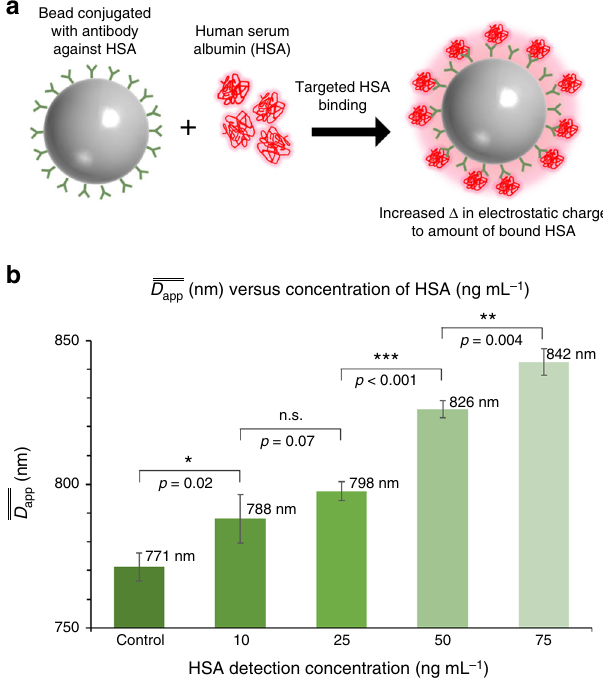
Fig. 6 Detection of HSA using antibody coated beads. a Schematics showing the detection of human serum albumin with the capture of antibody for higher detection sensitivity. b Three sets of readings were performed for the detection of HSA from 10 to 75 ng mL − 1 ( n = 3). D app represents the mean of mean D app for the three data sets with SD as the error bars (Supplementary Fig. 13). Independent two-sample t -test is used for the statistical analysis. Where * p < 0.05, ** p < 0.01, *** p < 0.001, and n.s. = not signi fi